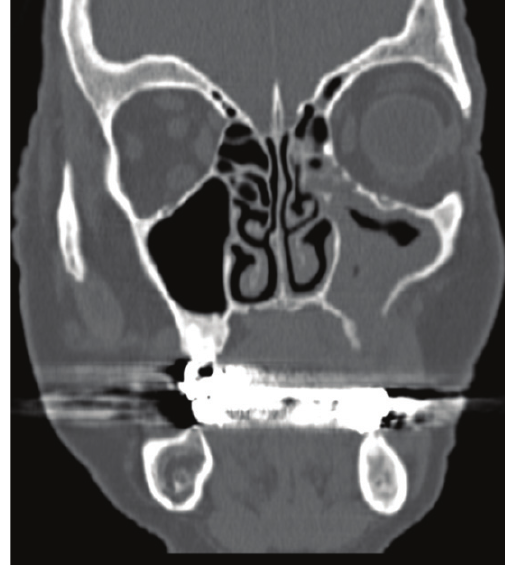
Figure 2: CT image of patient’s maxilla showing sinusitis for maxillary sinus involvement by BRONJ disease.